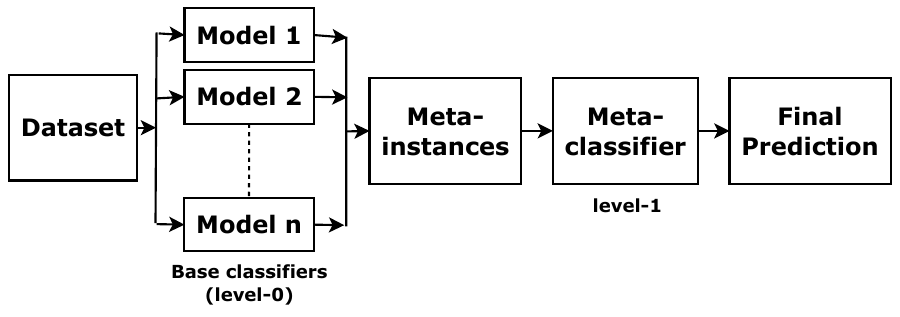
Figure 4. The concept of